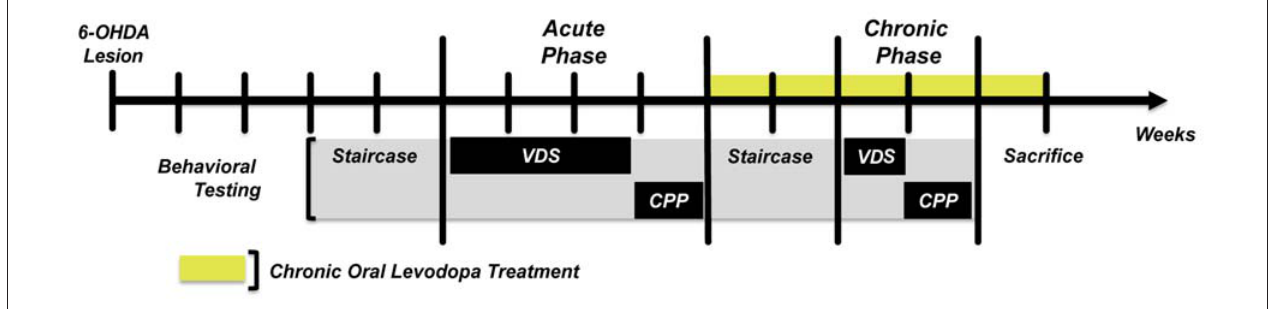
FIGURE 1 | Graphic representation of the experimental design. Staircase—Forelimb skilled motor function. VDS, Variable delay-to-signal—Impulsive responding. All sham and 6-OHDA animals performed the task in both behavioral assessment phases. CPP, Conditioned Place Preference—Positive reinforcement. For CPP, sham and 6-OHDA groups were divided in two subgroups, one performing the task in the acute phase and the other on the chronic phase. This was done to avoid possible conditioning memories created during the acute phase from biasing conditioned responses in the chronic phase.